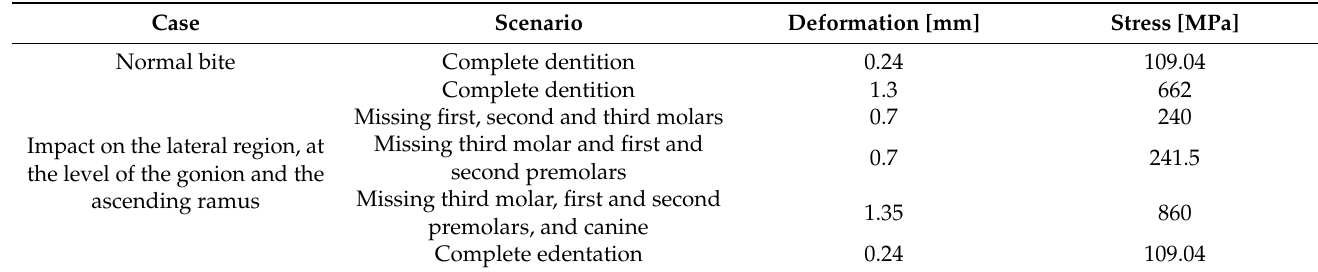
Table 2. Total deformation and equivalent stress on the surface of the condyle, in case of impact on the lateral area, at the level of the gonion, and the ascending ramus.